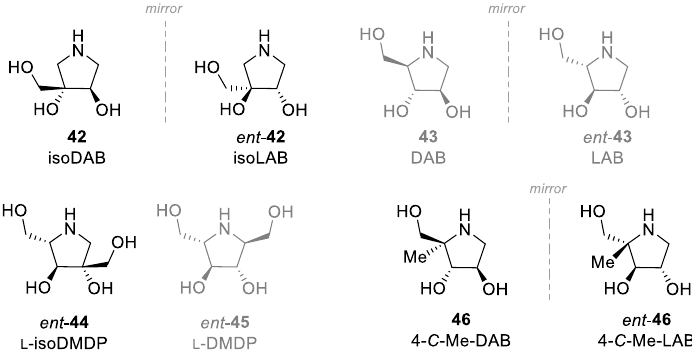
Figure 10. Carbon-branched pyrrolidine iminosugars.